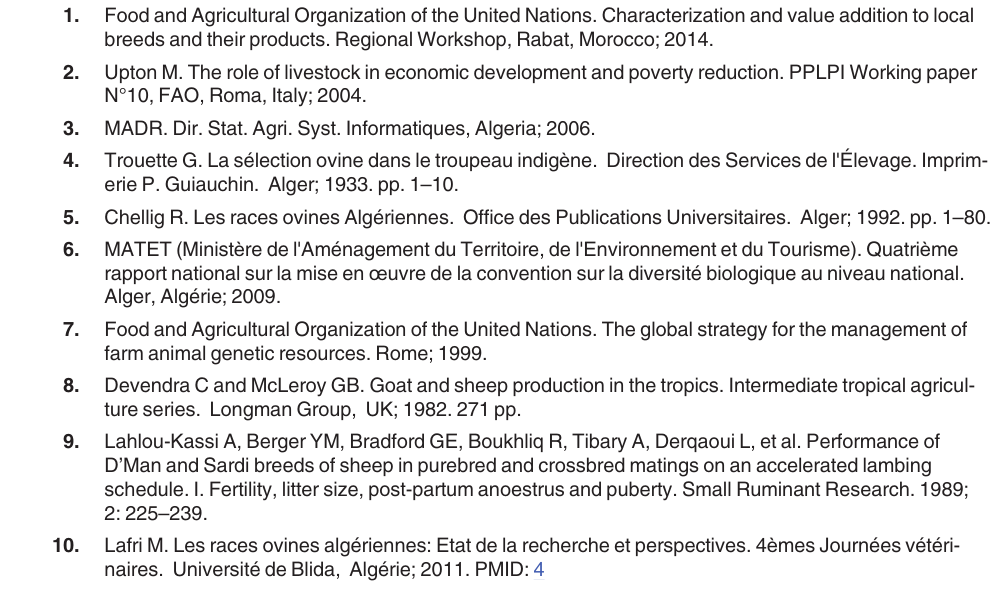
S3 Table. The data file consists of microsatellite allele lengths for 30 loci described in the paper. The data file has individuals organized in rows, with the name of the population in the first column. The subsequent columns correspond to microsatellite data (two columns per locus). Missing data are coded by zeros. S1 Fig. Geographical location of the sampling sites for the six Algerian breeds. Hamra, latti- tude: 34° 45' 34.06"N longitude: 0° 8' 44.51"E; Rembi, lattitude: 35° 13' 12.84"N longitude: 2° 19' 2.04"E; Ouled-Djellal, latitude: 36°17'N longitude: 6°37'E; Sidaoun, latitude: 22°47'N longitude: 5°31'E; Taâdmit, latitude: 34° 43'N longitude: 3° 13'E; D ’ man, latitude: 31°37'N longitude: 2°14' W. S2 Fig. Photography of rams for each considered Algerian breed. On the top, the three “ white breeds ” (from the left to the right: Ouled-Djellal — Taâdmit — Rembi); on the bottom, from the left to the right: Sidaoun — D ’ Man — Hamra.